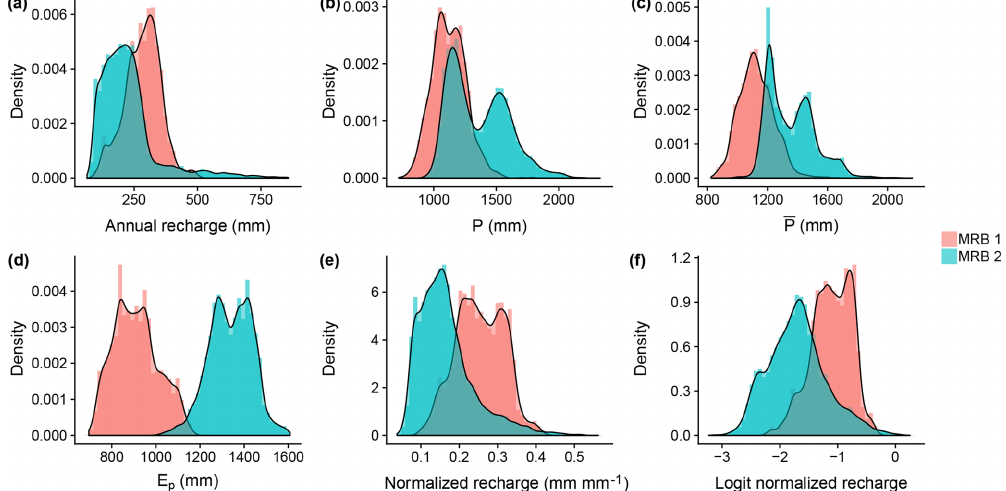
Figure 4. Histograms of (a) annual recharge in 2002, (b) annual precipitation in 2002, (c) long-term average annual precipitation, (d) long- term average annual potential evapotranspiration, (e) normalized recharge, and (f) logit normalized recharge (LNR) at all the watersheds in MRB 1 and 2. The black curves are estimates of the distributions based on kernel density